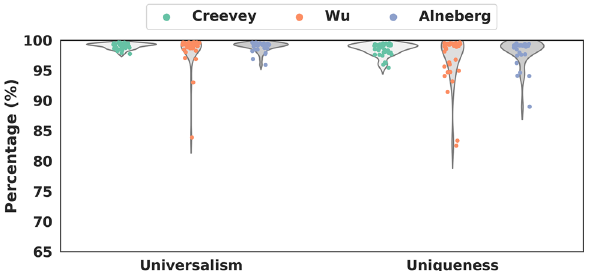
Figure 2. The universalism and uniqueness of the three USCG sets. Universalism means how many percent of genomes has at least a copy of a USCG. Uniqueness refers to the percentage of genomes with only one copy of a USCG.